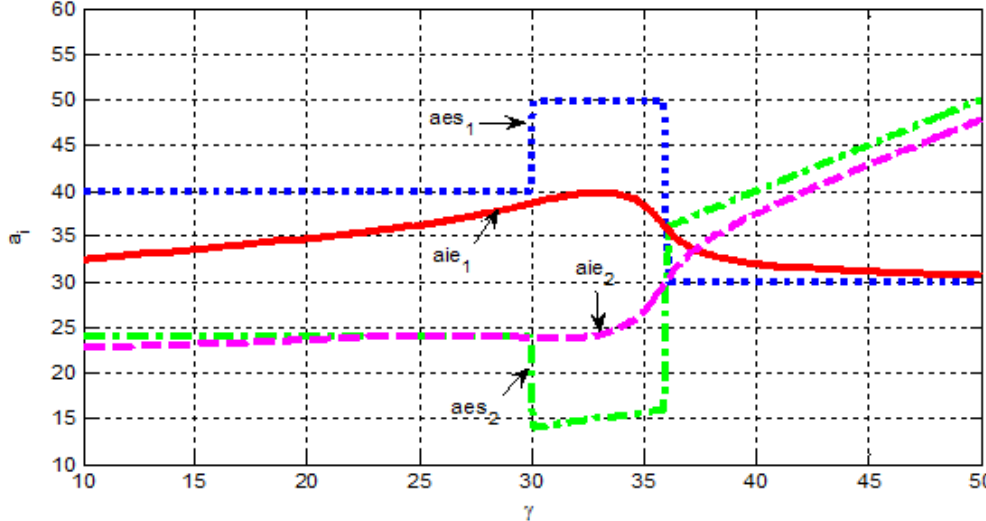
Figure 2. Aumann-Shapley values dynamics with g based on different risk